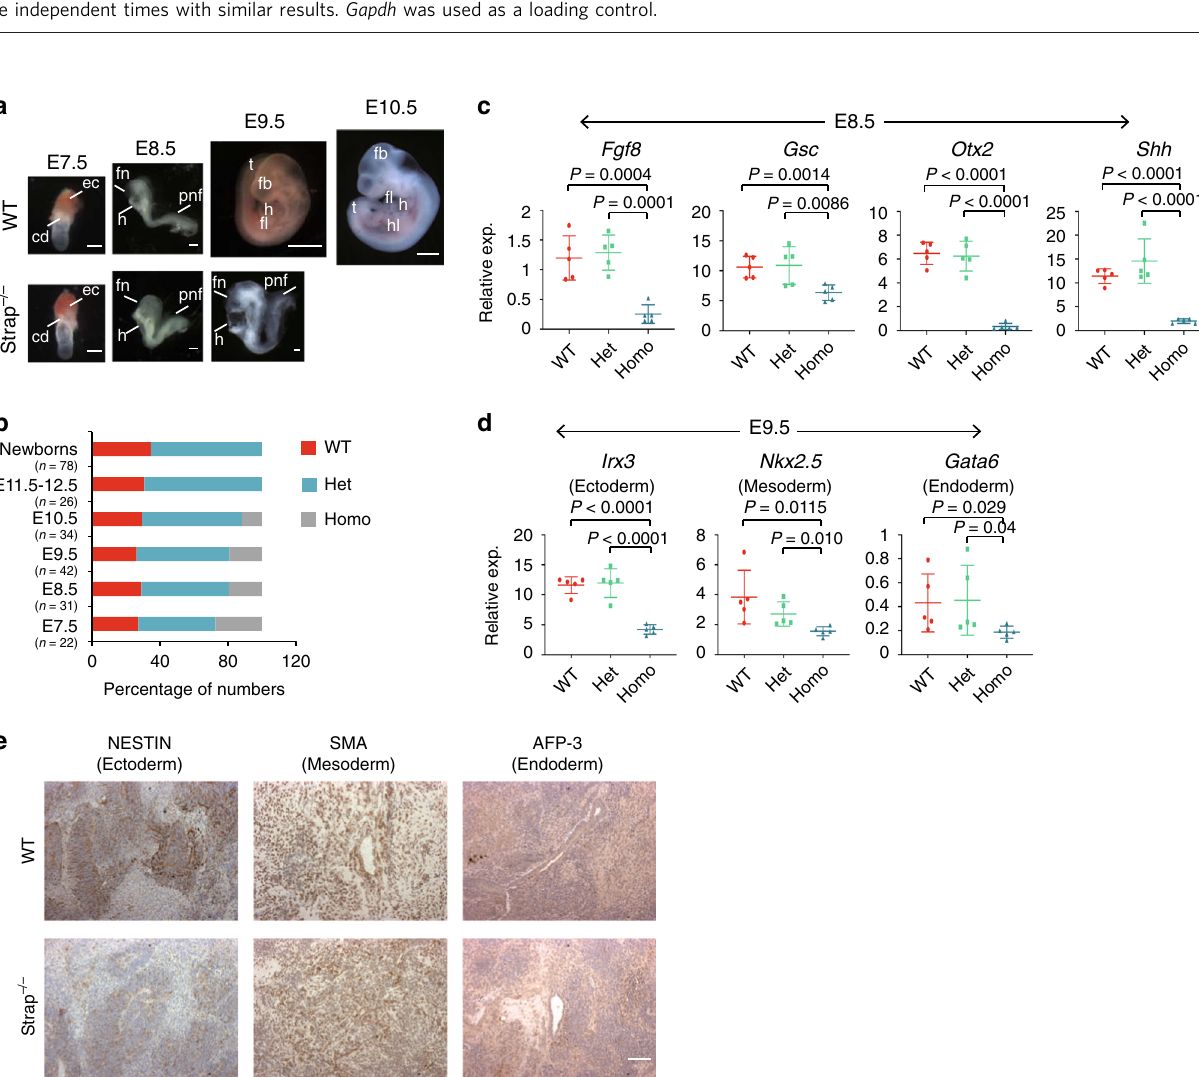
Fig. 2 Genetic deletion of Strap causes mouse embryonic lethality. a Representative litters of E7.5 – 10.5 embryos from intercrosses of B6 Strap + / − mice. Compared with a wild-type E9.5, a Strap − / − embryo shows size and morphological defects. For E7.5 – E8.5 embryos, the experiment was repeated fi ve independent times with similar results. For E9.5 – E10.5 embryos, fourteen independent experiments were repeated and had similar results. For E7.5 – 8.5 and E9.5 Strap − / − embryos, scale bar equals 300 µ m. For E9.5 WT and E10.5 embryos, scale bar equals 1 mm. ec, ectoplacental cone; cd, chorionic dome; fn, frontonasal region; h, heart; pnf, posterior neural folds; fb, front brain; fl , front limb; hl, hind limb; t, tail. b Histograms showing the survival percentages of embryos or pups from three genotypes at the indicated time. c , d qRT-PCR was used to quantify the relative mRNA levels in E8.5 ( c ) and E9.5 embryos ( d ). P -values based on unpaired two-tailed Student ’ s t -test. Error bars indicate the mean ± SD from n = 5 biological replicates. WT, wild type; Het, heterozygous; Homo, homozygous. Data represent one of three independent experiments. e Paraf fi n embedded tissue sections from mouse ESC teratomas were stained with three germ-layer markers as indicated. The experiment was repeated two independent times with similar results ( n = 3 biological replicates per group). Scale bar, 50 µ m. Magni fi cation,